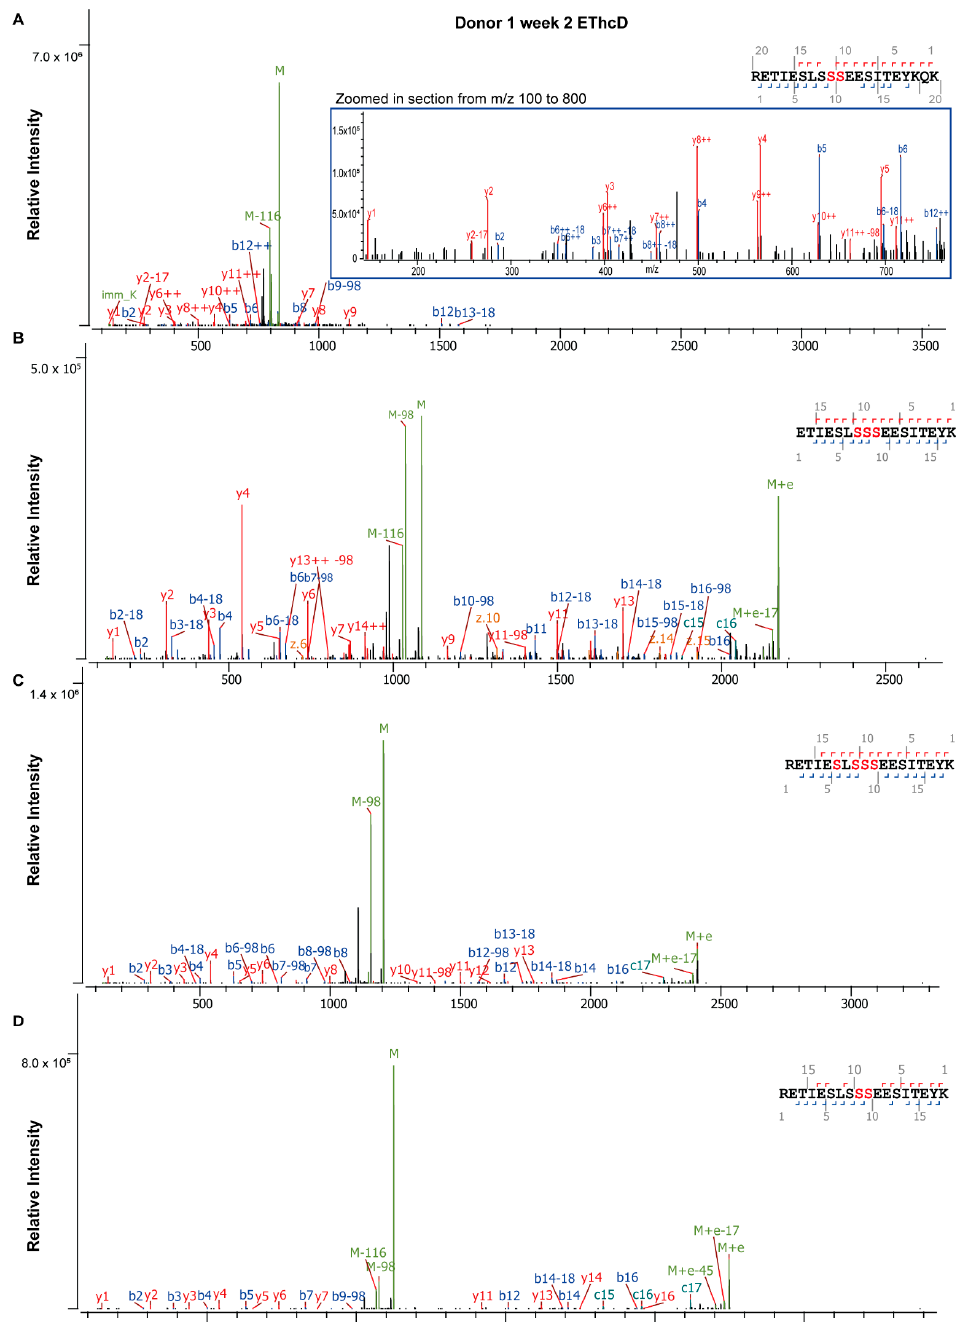
Figure 3. Illustrative EThcD fragmentation spectra of β -casein phosphopeptides. The N-terminal peptide 16 RETIESLSSSEESIT 30 with up to seven phosphosites is depicted with varying degrees of site occupancy in the